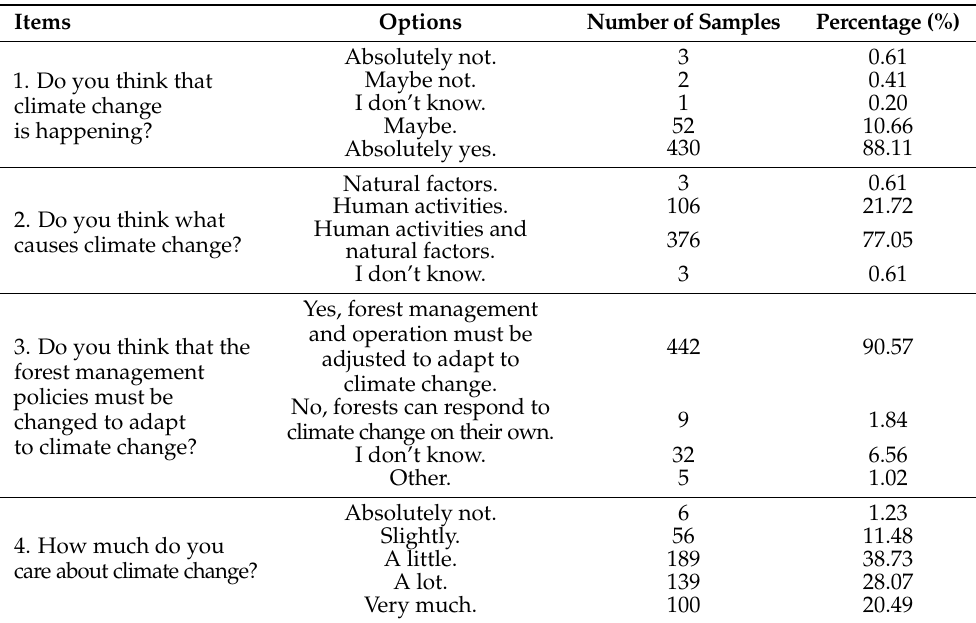
Table 4. Respondents’ awareness toward climate